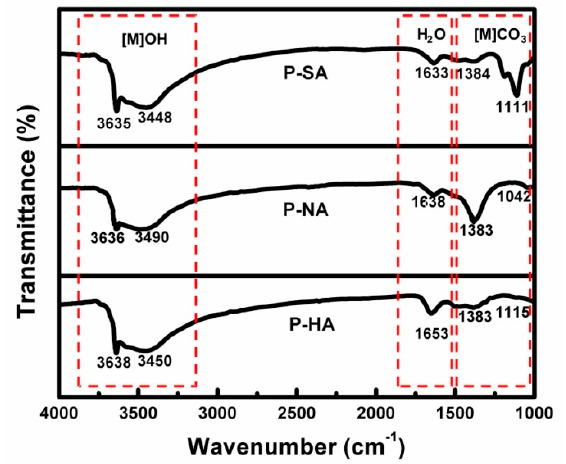
Figure 7. FT-IR analysis of the –OH precursor from the leachates of H 2 SO 4 , HNO 3 , and HCl; denoted as P-SA, P-NA, P-HA (M: metal).